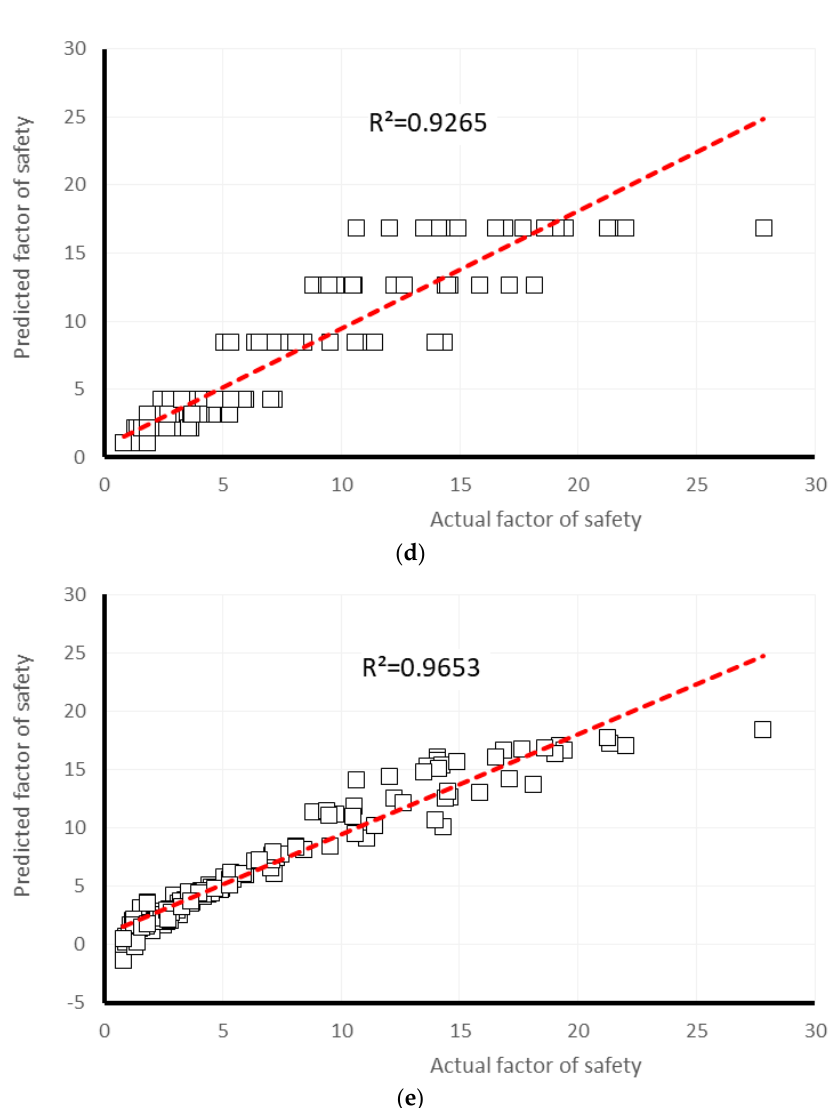
Figure 6. The results of correlation obtained for the testing datasets after conducting various models in predicting safety factor: ( a ) Gaussian processes regression, ( b ) multiple linear regression, ( c ) multi-layer perceptron, ( d ) simple linear regression, ( e ) support vector regression The graphical view of the computed error (the difference between the observed and predicted slope safety factor) for all employed models is depicted in Figure 7. As is obvious in this chart, the less distance from the y = 0 axis (i.e., the lowest error), results in higher accuracy. In this subject, the MLP and SVR models have presented the most reliable prediction, due to the higher aggregation of their results around the y = 0 axis, particularly for the first 350 data. In contrast, the maximum observed error is obtained for the SLR estimation, which reaches more than ten units, for both negative and positive error.